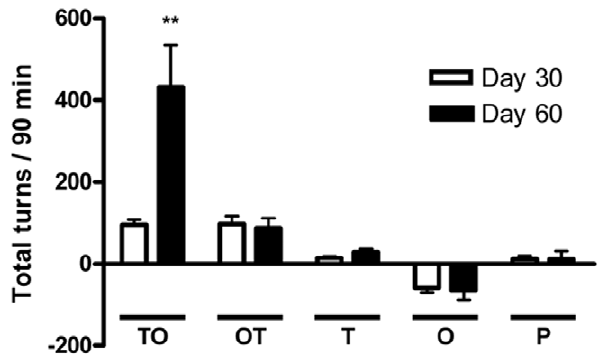
Figure 6. Methamphetamine-induced turning behavior in rats transfected with several plasmids. The plasmids were pCMV-TCII- OLEO coding for transcobalamin-oleosin (TO), pCMV-OLEO-TCII coding for oleosin-transcobalamin (OT), pCMV-TCII coding for transcobalamin II (T), pCMV-OLEO coding for oleosin (O), and pCDNA3 (P). The values are the mean 6 SEM of 3 animals per group. **=Significantly different from control groups. P , 0.01, repeated-measures two-way ANOVA and Bonferroni post-test.